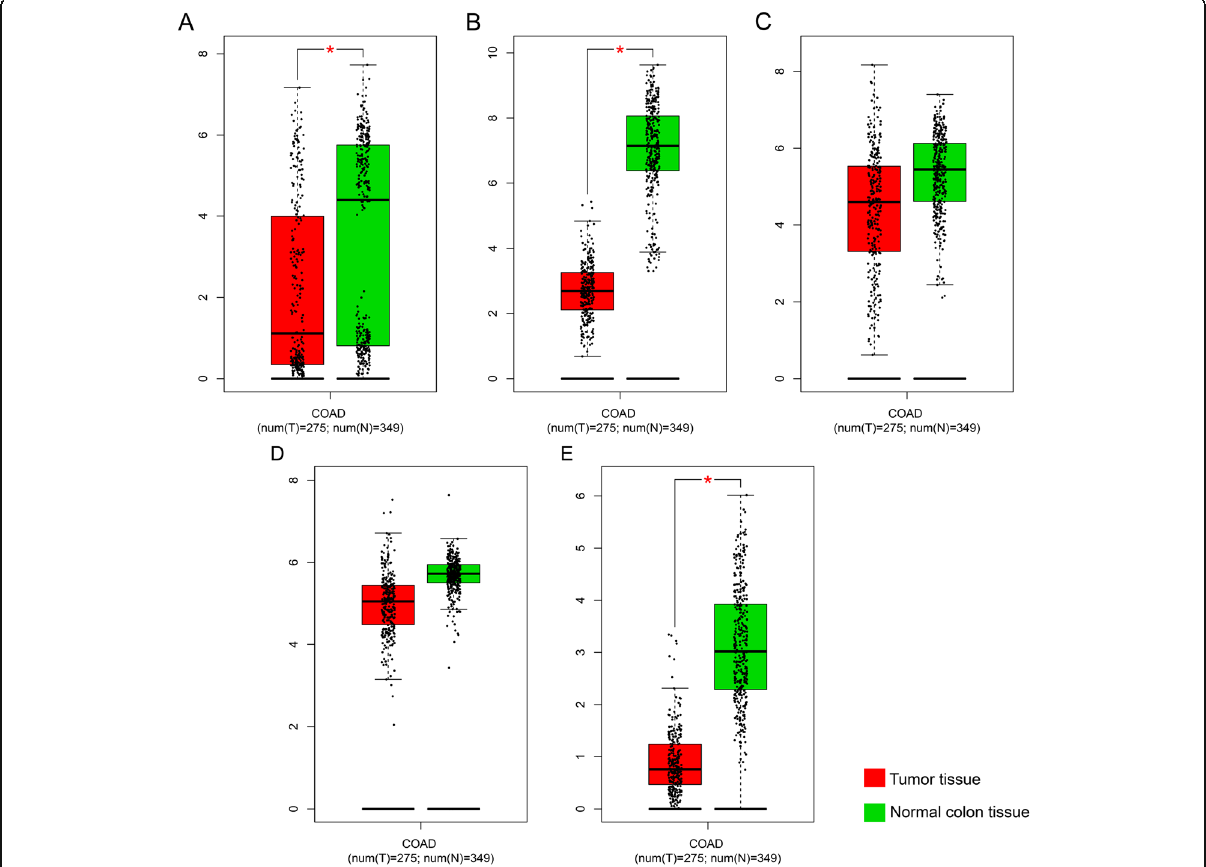
Fig. 1 Boxplots for GSTM gene family expression in colon tumor and normal tissues by Gene Expression Profiling Interactive Analysis (GEPIA). ( a ) GSTM1; ( b ) GSTM2; ( c ) GSTM3; ( d ) GSTM4; ( e )